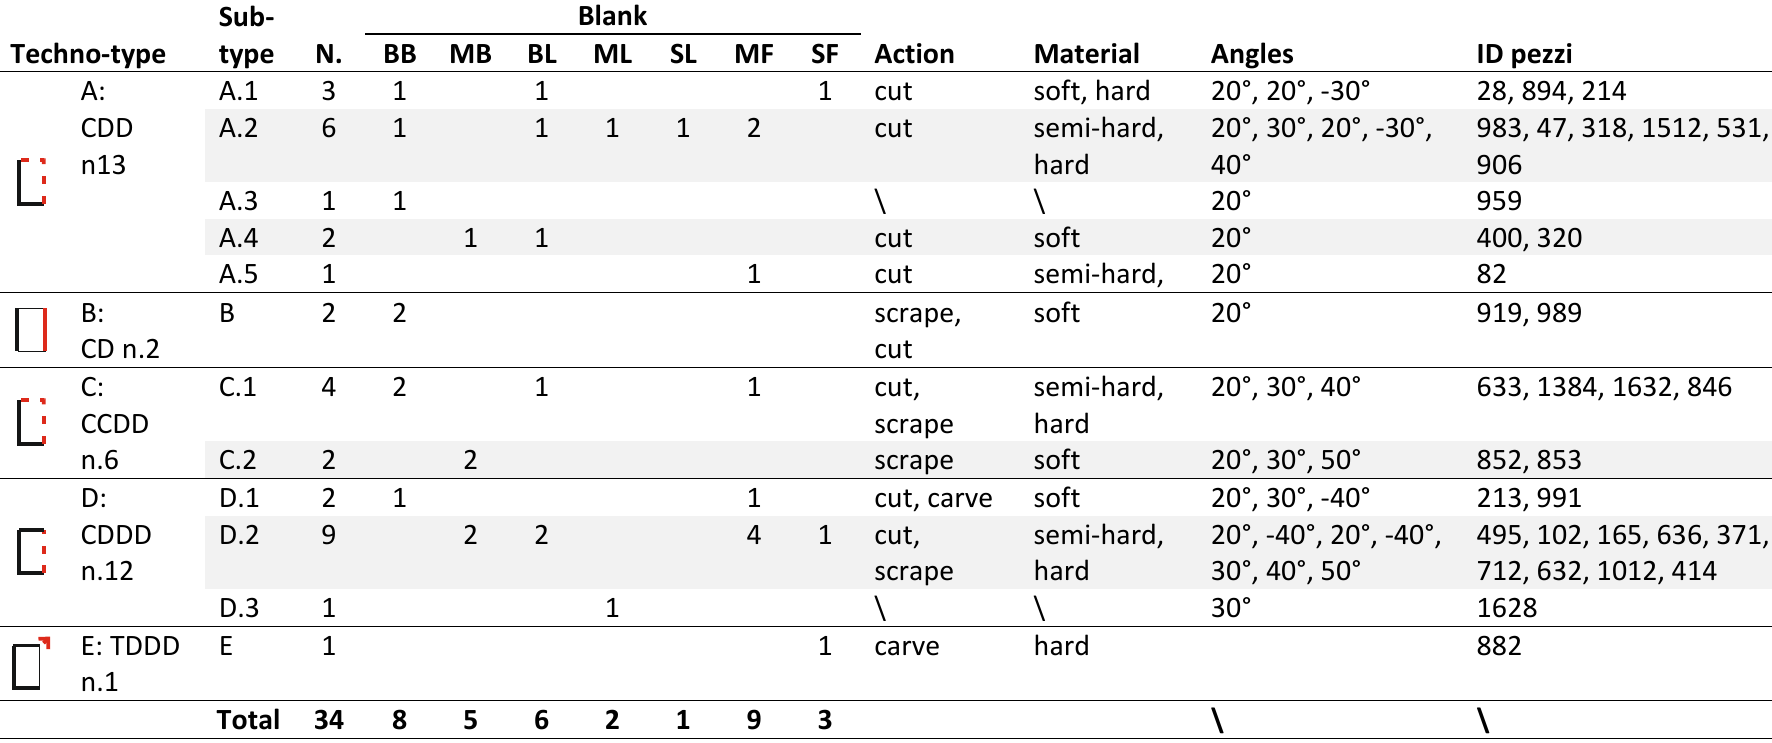
Table 8. Synthetic table of techno-types and sub-types (C: cutting edge, T: trihedron: D: backed side; n. refers to the total number of pieces of each type), how they are disposed on the blank, plus information regarding the use: action, worked material and angles of the active edge (for the blank: BB: big blade, MB: medium blade, BL: big long flake, ML: medium long flake, SL: small long flake, MF: medium flake, SF: small